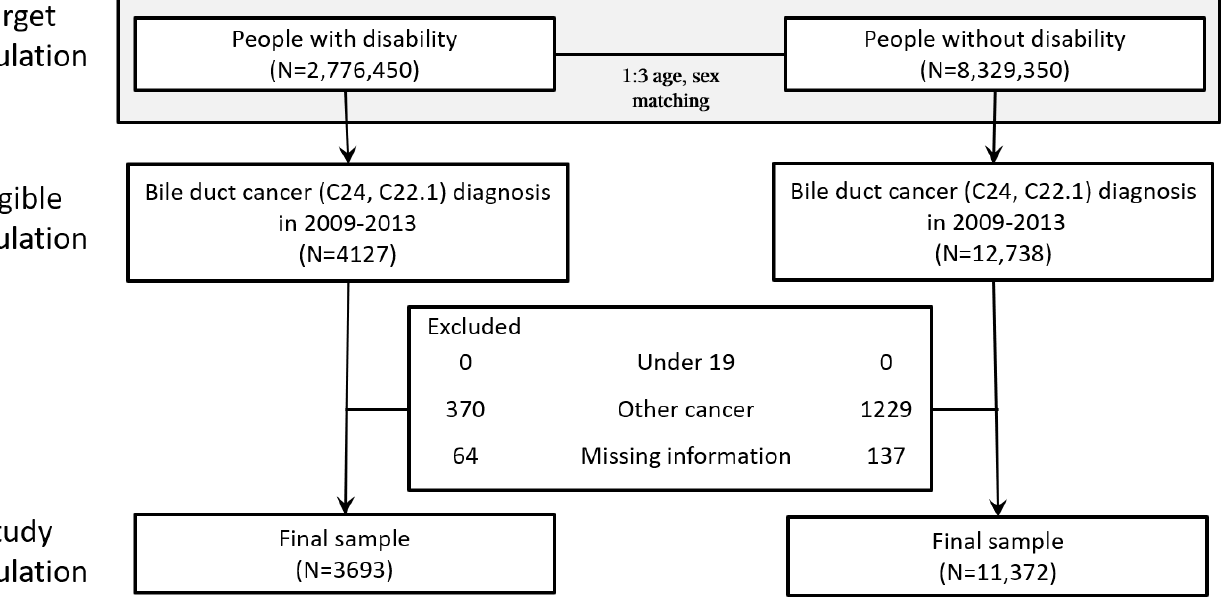
Figure 1. CONSORT